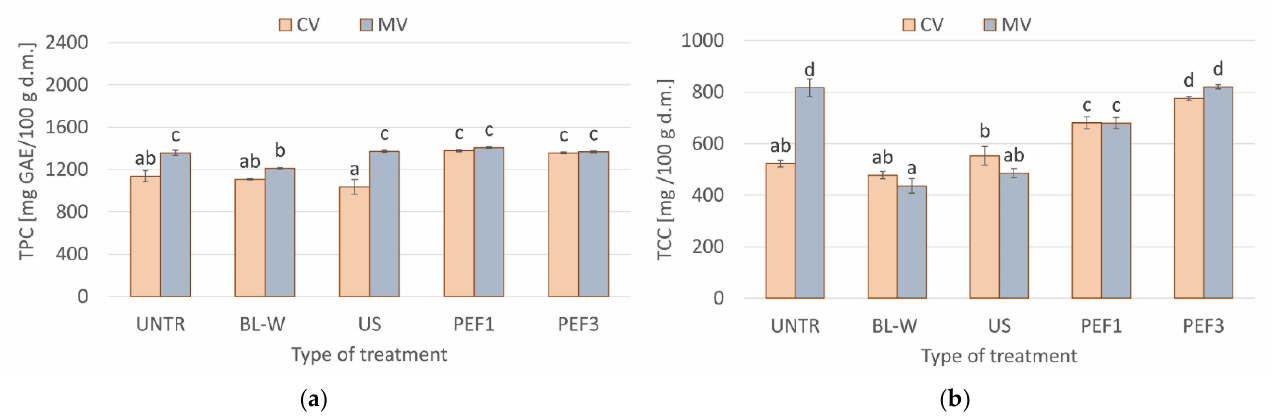
Figure 5. Comparison of ( a ) total phenolic content (TPC) and ( b ) total carotenoids content (TCC) for convective (CV) and microwave – convective (MV) dried red bell pepper subjected to thermal or non-thermal treatment prior to drying. Column presents a mean (from 3 repetitions), and errors bars show standard deviation. The different letters above columns show different homogeneous groups (Tuk ey’s HSD, α =